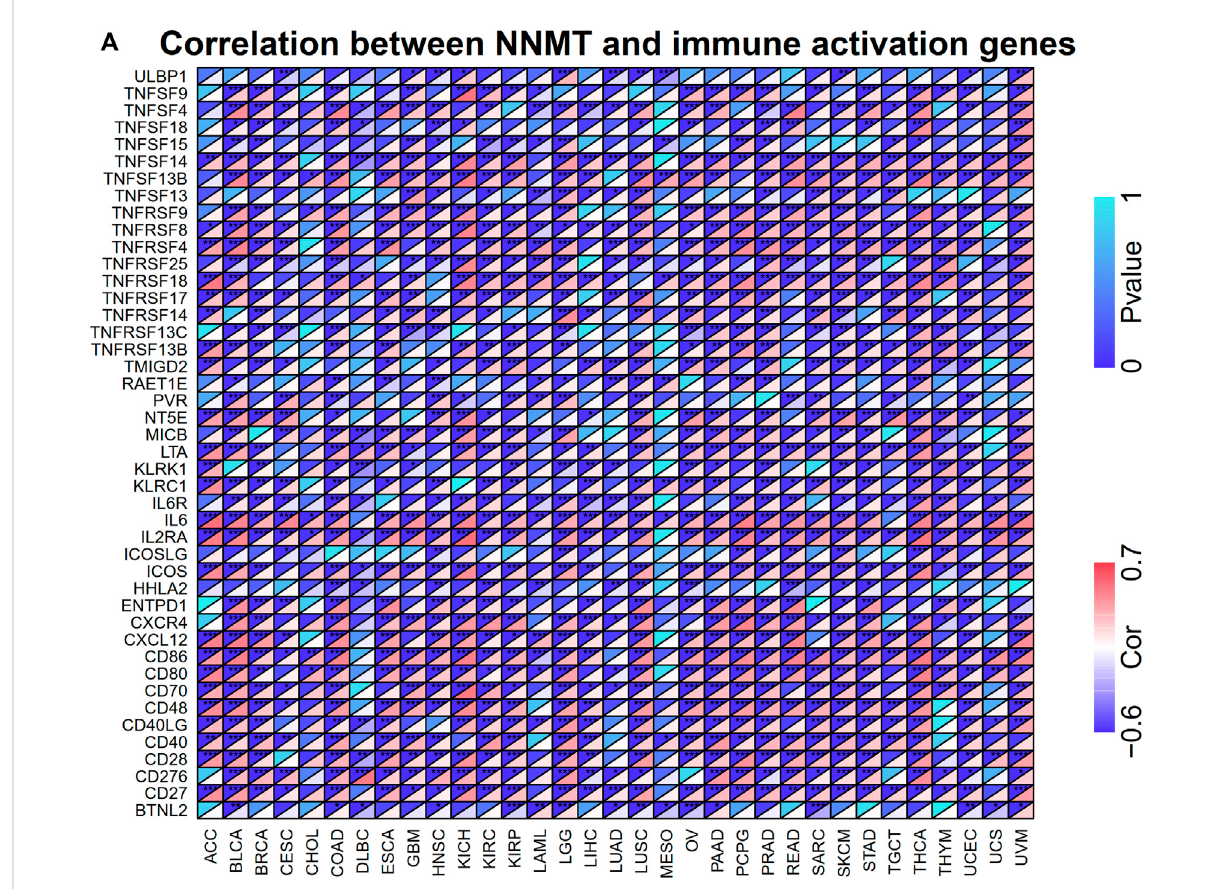
FIGURE 9 Co-expression ofNNMTwithgenesinvolvedinimmunity.ThetriangleintheupperleftcornerindicatedtheP-value,whereasthetriangleinthe lower right corner represented the correlation coef fi cient. (A) The expression of NNMT was positively associated with immune activation markers suchasCD86,CD27,andIL-6.ExpressionofNNMTwaspositivelycorrelatedwiththemajorityofchemokinesgenes (B) andaportionofchemokines receptors, including CCR1, CCR2, and CXCR6 (C) . NNMT expression was favorably associated with the majority of MHC genes (D) , as well as immunesuppressive genes including HAVCR2, CTLA4, and CSF1R (E) . (* p < 0.05, ** p < 0.01, *** p <